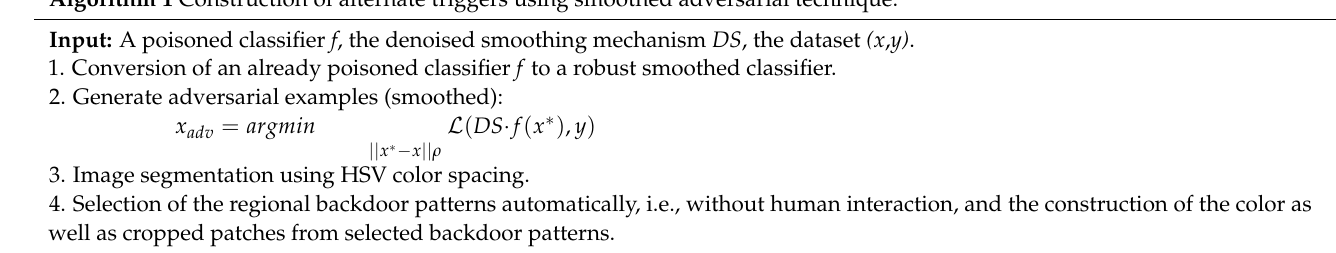
Algorithm 1 Construction of alternate triggers using smoothed adversarial technique.